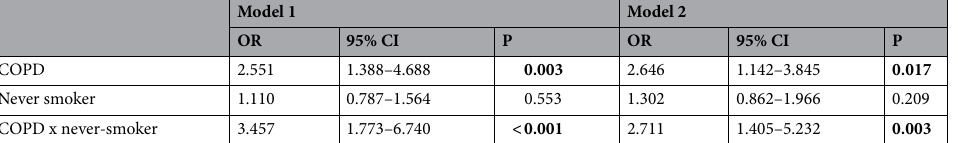
Table 3. Logistic regression analysis to identify association between obstructive pulmonary disease, smoking status and glaucoma in women. Model 1 univariate analysis; Model 2 multivariate analysis adjusted for age, refractive status, IOP, BMI and HTN. OR odds ratio, CI confidence interval, COPD chronic obstructive pulmonary disease. Significant values are in bold. A P-value < 0.05 was considered statistically